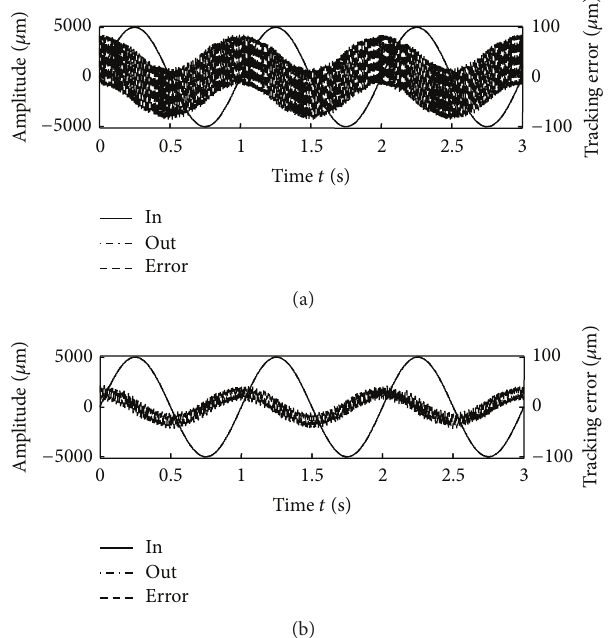
Figure 8: (a) PID 100Hz. (b) PID + ZPETC